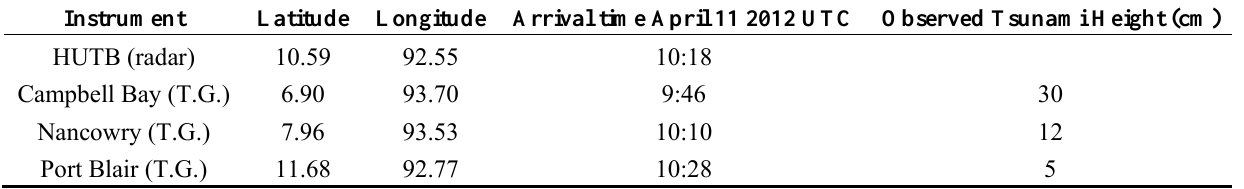
Table 3. Comparison of tsunami arrival times from the HUTB radar and neighboring tide